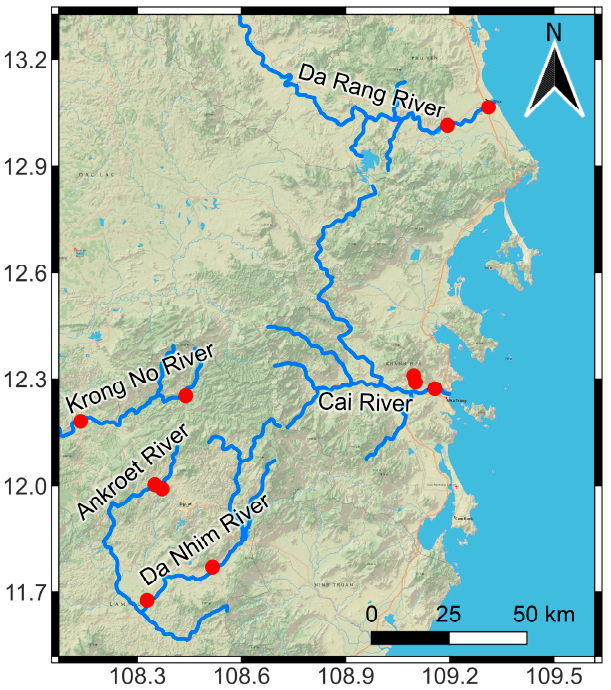
Figure 1. Geographical position of macroplastics sampling (red dots) (QGIS 3.26.2).